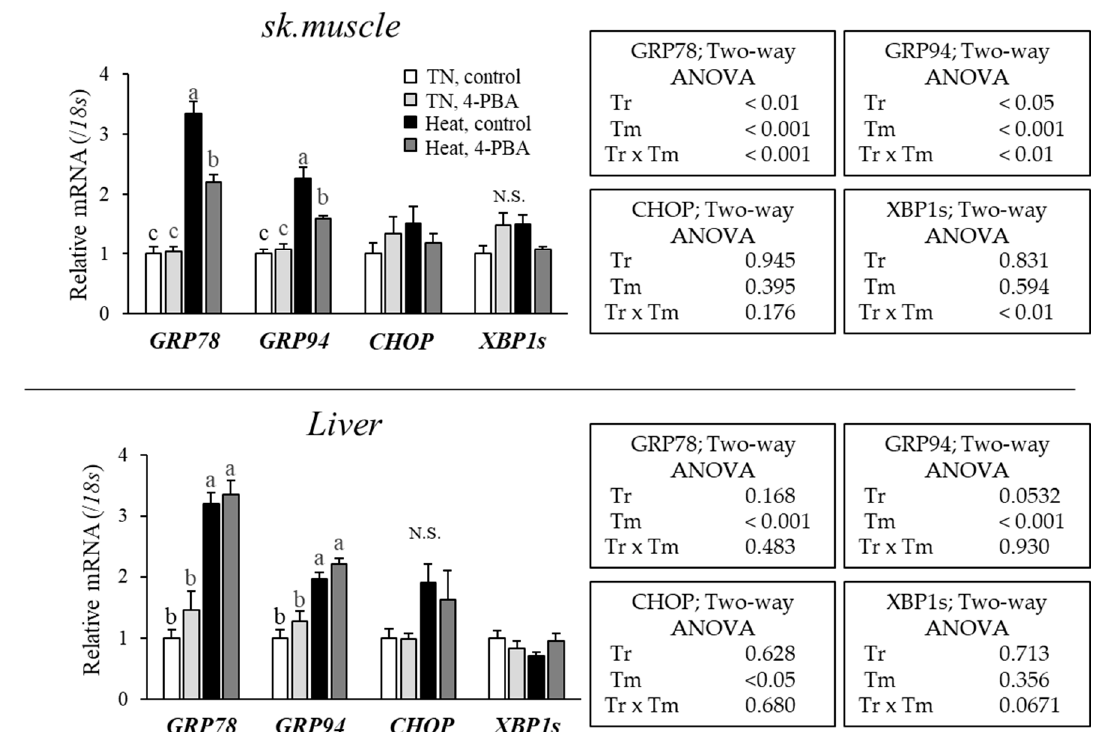
Figure 3. Effects of 4-PBA on UPR relative gene expression in the skeletal muscle and liver under acute HS. Relative mRNA expression of UPR relative genes (GRP78, GRP94, CHOP, and XBP1s) of thermoneutral (TN) and HS broiler chickens fed control or 4-PBA diet. Data show means + SE ( n = 6–7). Different letters indicate statistical significance ( p < 0.05). Tr: treatment; Tm: temperature.